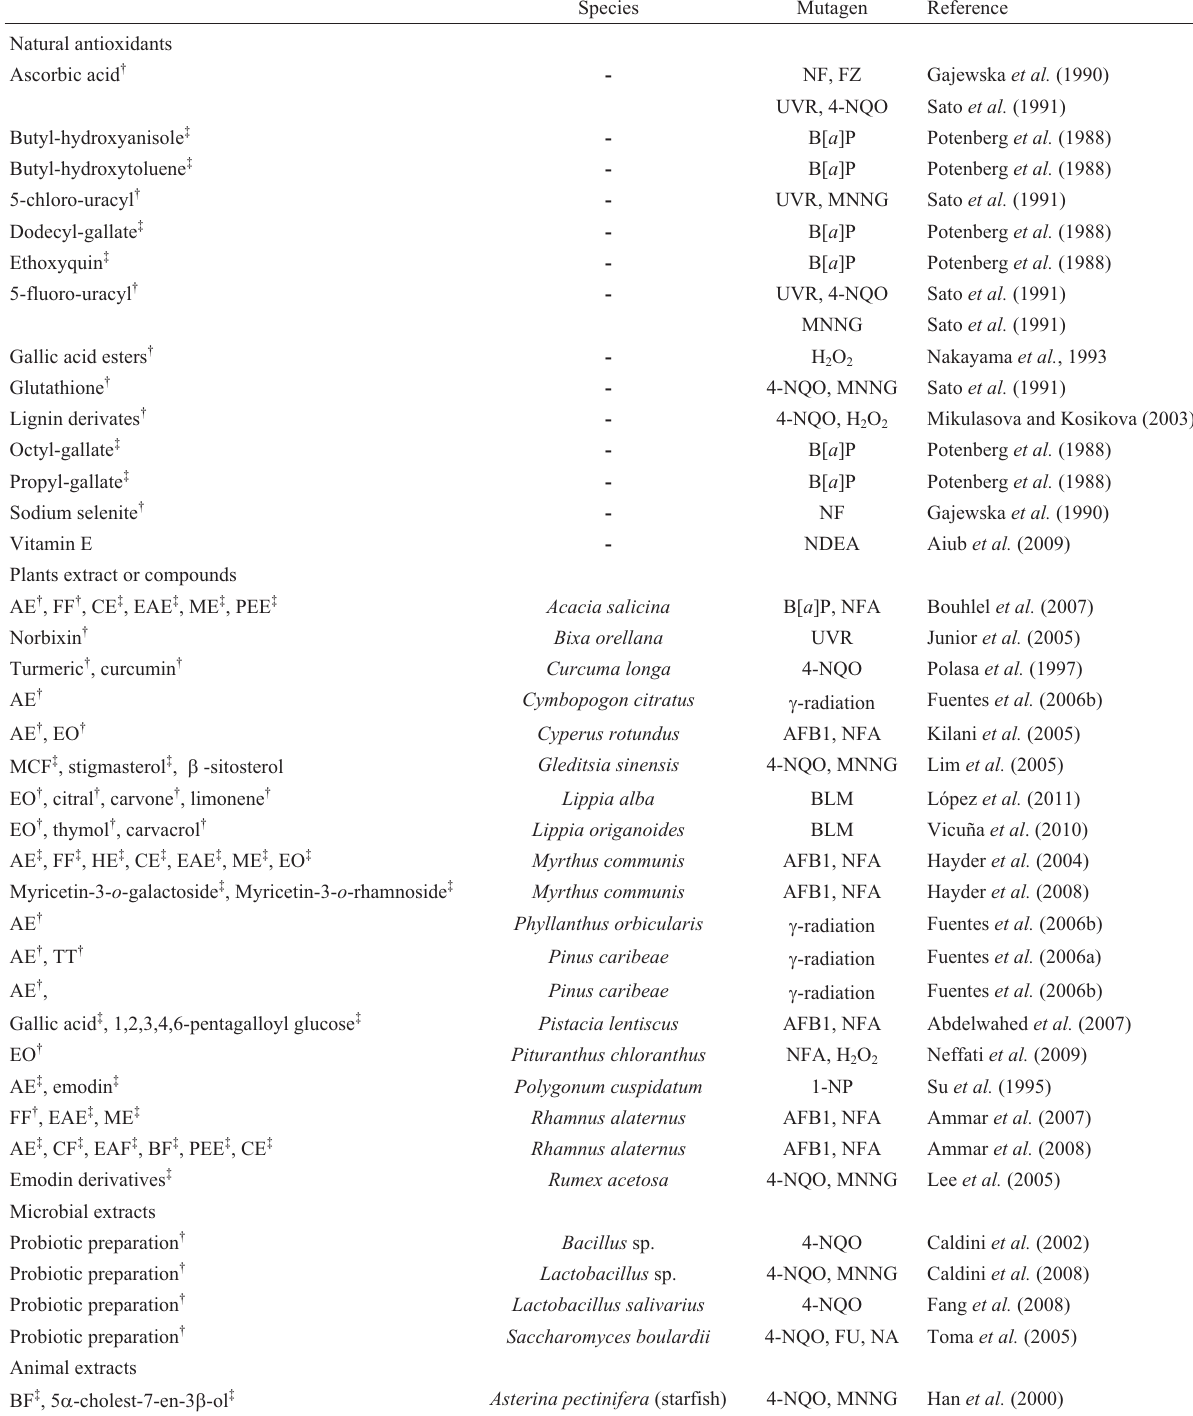
Table 6 - Antimutagenicity of different compounds and biological extracts detected with the SOS